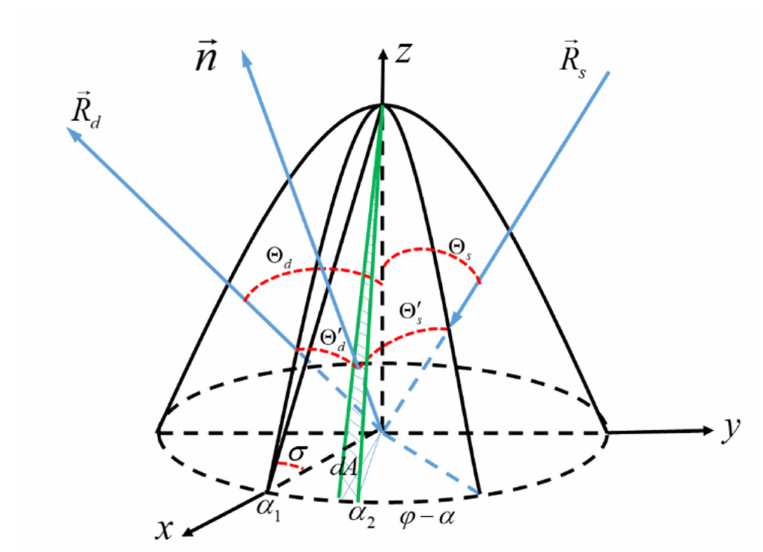
Figure 2. Radiative transfer model of conical space